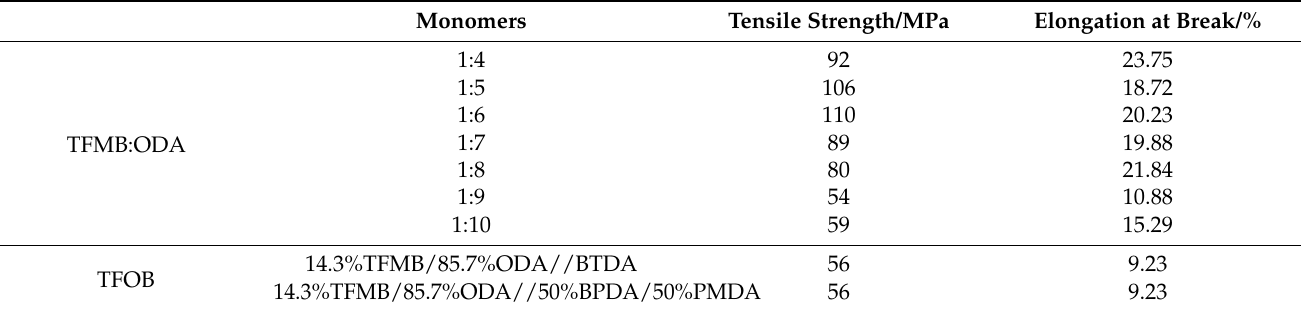
Table 5. Mechanical properties of PI films in group TFOP and group